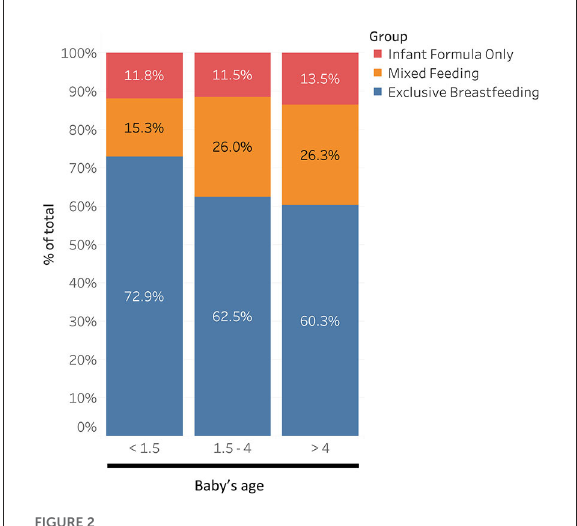
FIGURE2 Distribution of feeding practices according to baby’s age.